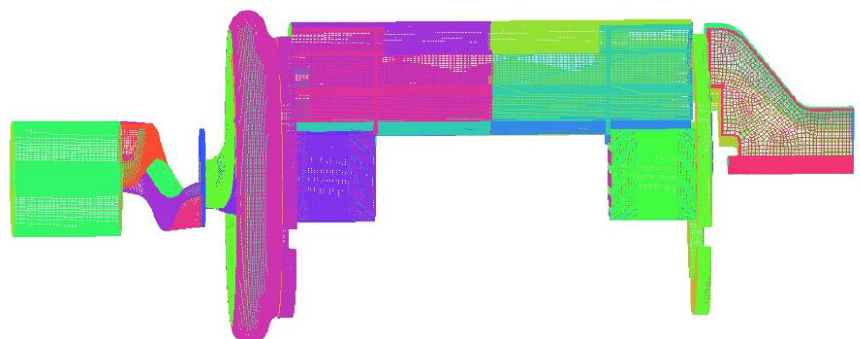
Figure 2. The mesh of low specific speed high-speed centrifugal pump. To test the influence of grid density on the results, five cases with different grid num- head almost keeps unchanged when the grid number is increased beyond eight million.